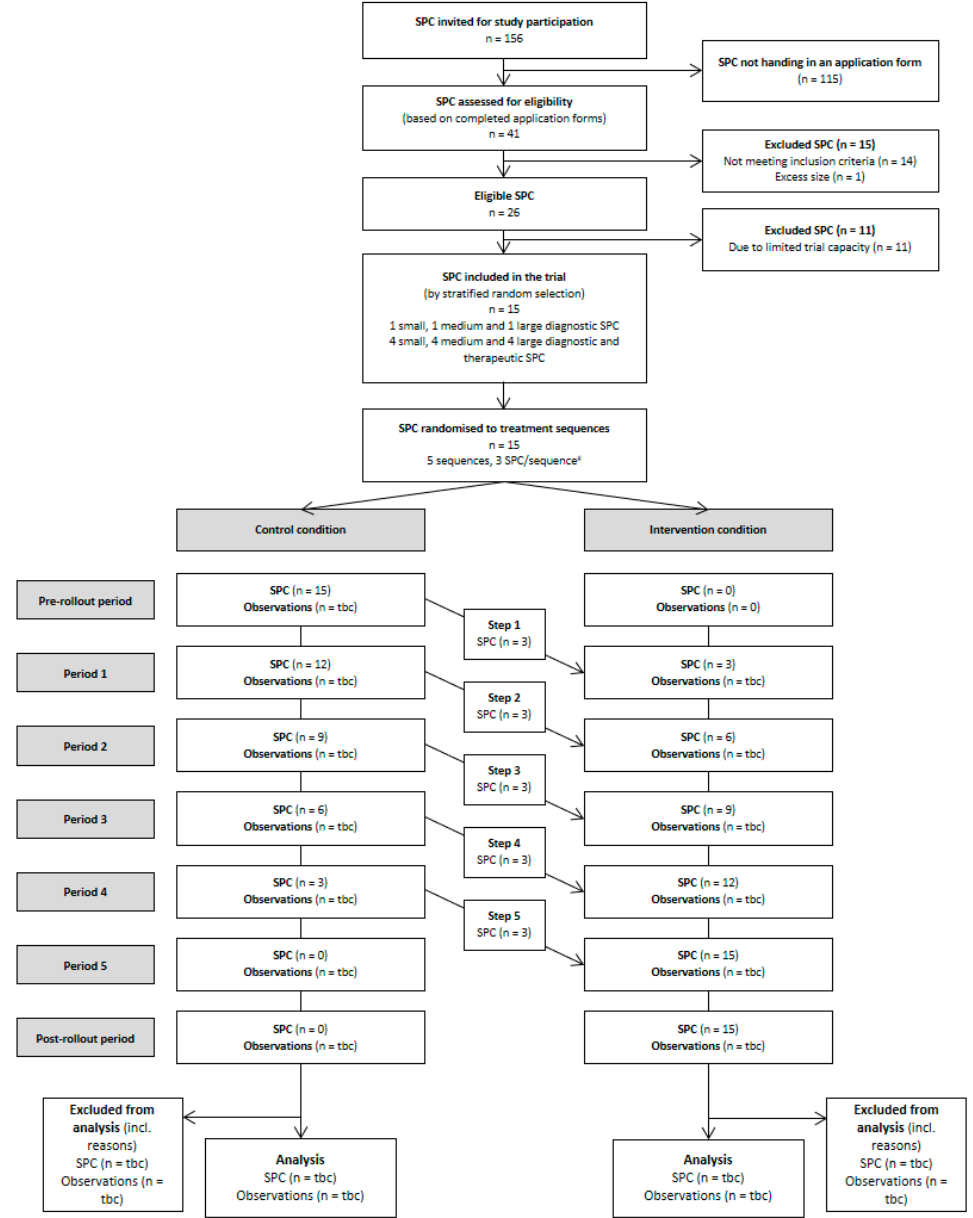
Figure 3. CONSORT flowchart for the primary endpoint. # After randomisation, but prior to the start of data collection, one medium-sized diagnostic SPC withdrew due to unforeseen circumstances during the study period. This SPC was replaced by a randomly selected study site belonging to the same stratum. SPC, social paediatric centre; tbc, to be completed after completion of data collection.